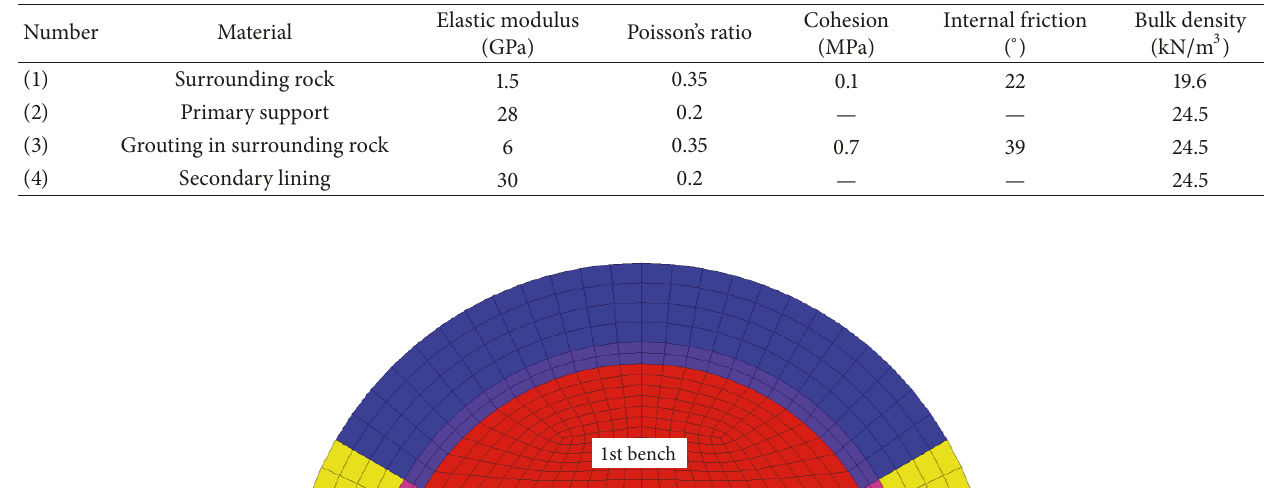
Table 1: Calculation parameters of the tunnel model.